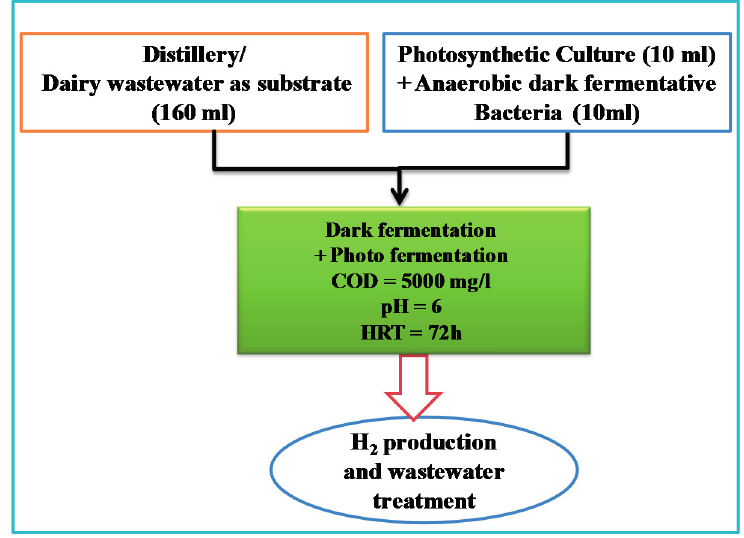
Figure 9. Schematic representation of experimental set-up